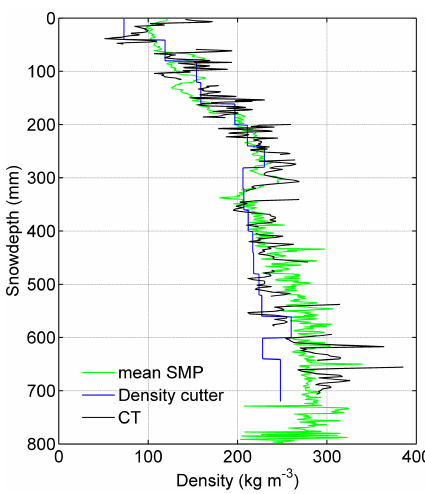
Figure 4. Density profile derived by SMP (green), µ CT (black) and density cutter (blue). The green line is the average of three neigh- boring SMP measurements.